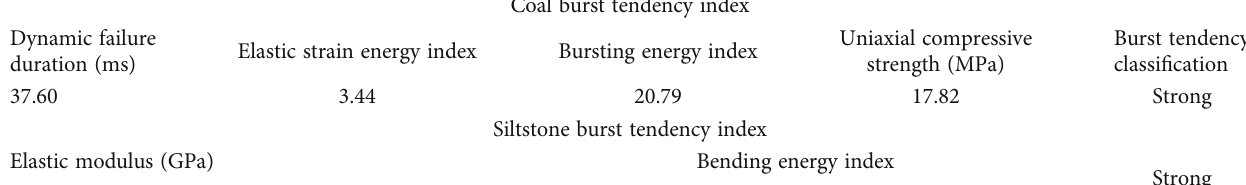
Table 1: Burst tendency index of the 3-3# coal seam and siltstone from Yutian coal mine.